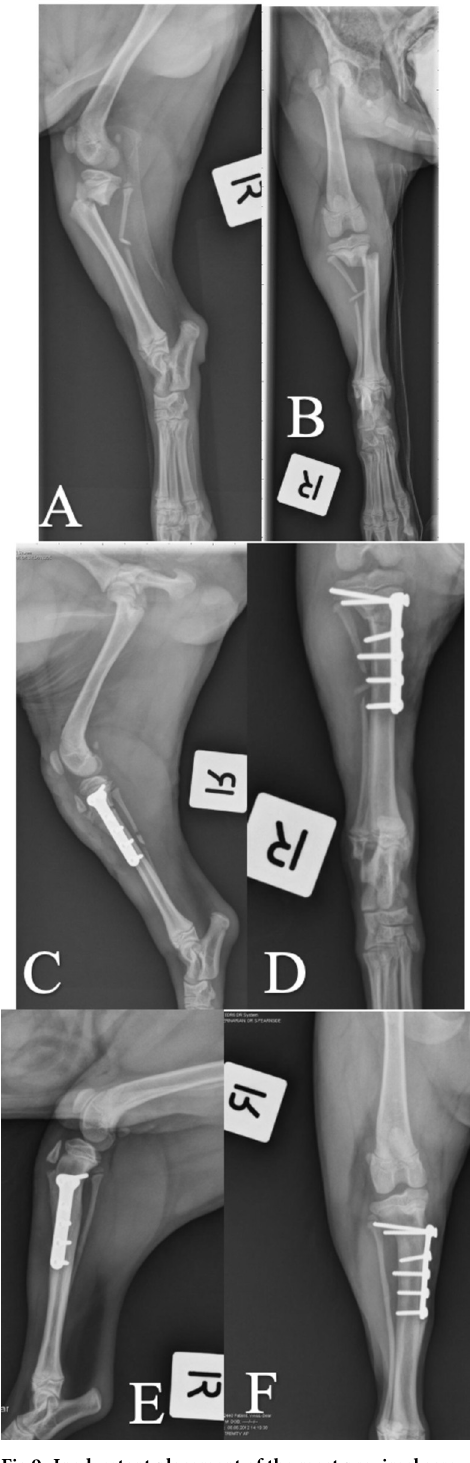
Fig 9. Inadvertent placement of the most proximal screw through the proximal tibial physis resulting in valgus deviation of the proximal tibia (Case 6). A and B: Mediolateral and craniocaudal views at time of fracture diagnosis. C and D: Immediate postoperative mediolateral and craniocaudal views. E and F: 6 weeks postoperative mediolateral and craniocaudal views.